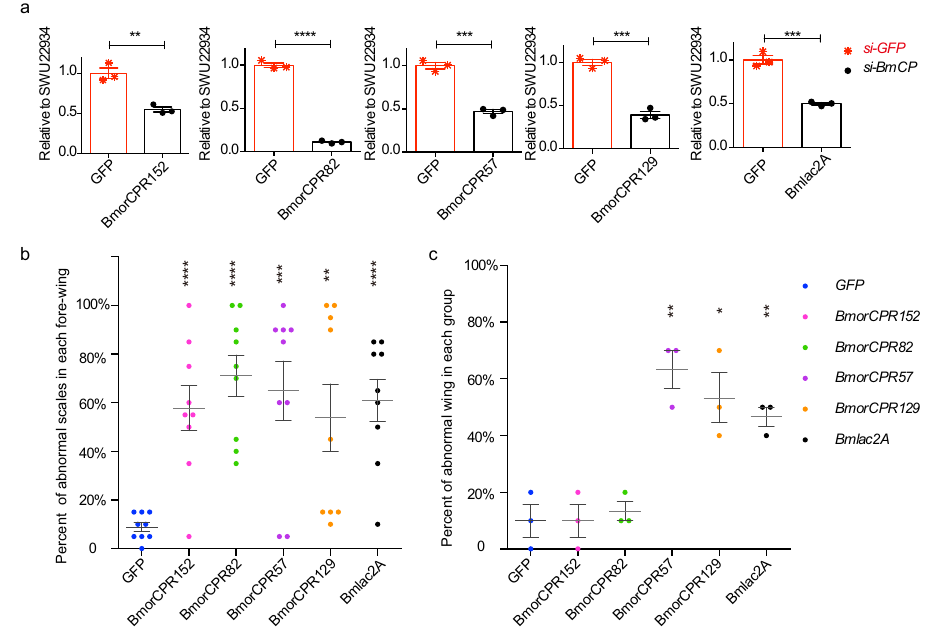
Fig. 2 Statistical analysis of abnormal wing scales and wing after knockdown of four His-rich CP genes and Bmlac2A by RNAi. a Reduction of mRNAs by siRNA con fi rmed by RT-qPCR ( n = 3). Red asterisks, control (GFP); black dots, siRNA treated. b Percent of abnormal wing scales after RNAi ( n = 9). c Percent of abnormal wings after RNAi ( n = 3). Blue, GFP control; magenta, BmorCPR152; green, BmorCPR82; purple, BmorCPR57, orange, BmorCPR129, black, Bmlac2A. Signi fi cance difference: * P value < 0.05, ** P value < 0.01, *** P value < 0.001, and **** P value <